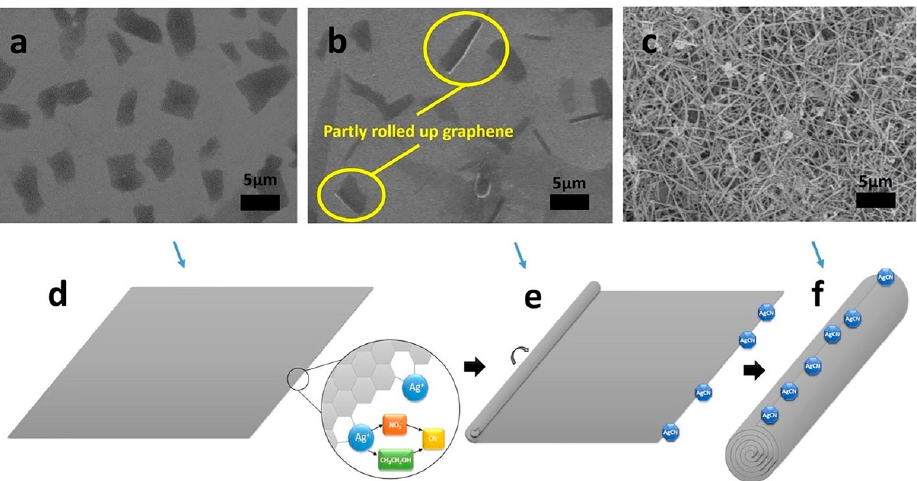
Figure 9. SEM images of the graphene NSHs ( a ), intermediate transition state ( b ) and the converted NSHs to NSCs ( c ). The speculation mechanism of the scrolling process of the graphene NSHs into the NSCs. A square graphene sheet and the position occupied with the created AgCN ( d ), the partially curled state of the graphene and the formed AgCN particles at the edge ( e ), and the final finished GNSs and formed AgCN particles on the surface of the GNSs ( f ). Reprinted from Ref. [93].